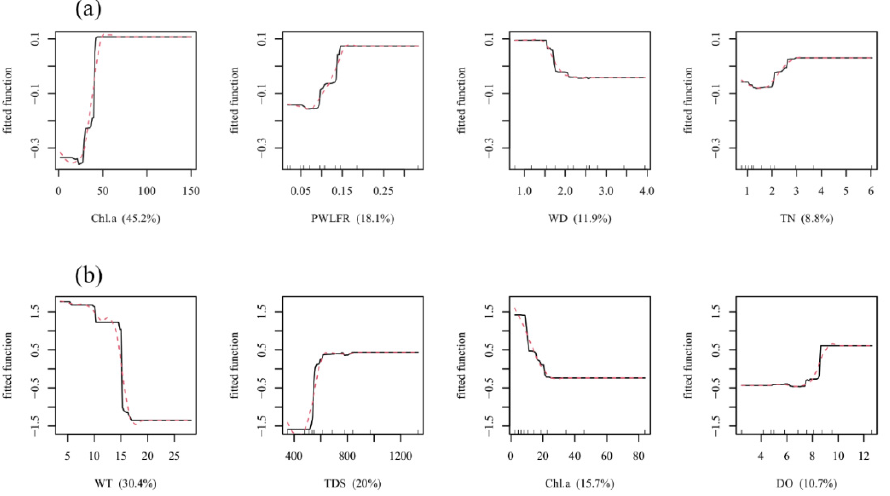
Figure 3. Seasonal pattern of macroinvertebrate species abundance and richness in Baiyangdian Lake (the same letters indicate nonsignificant differences; *** represents significant differences existing among seasons ( p < 0.001)).